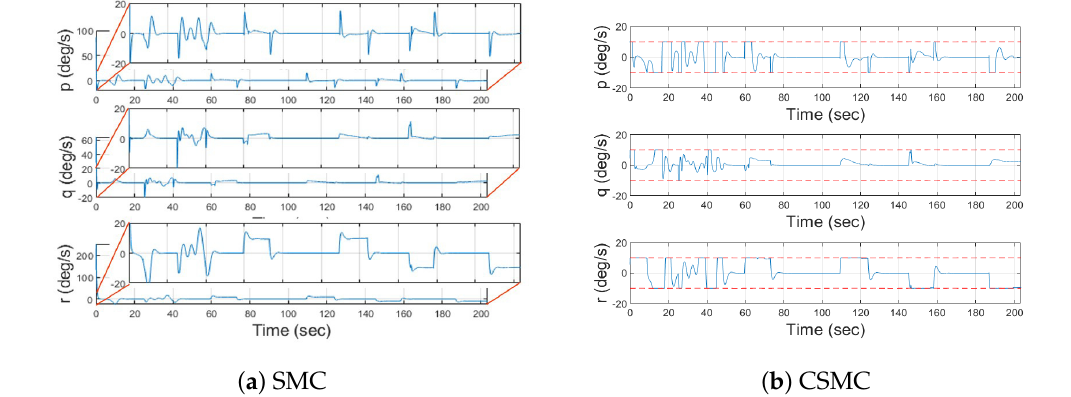
Figure 8. Angular rate responses of the UAV.